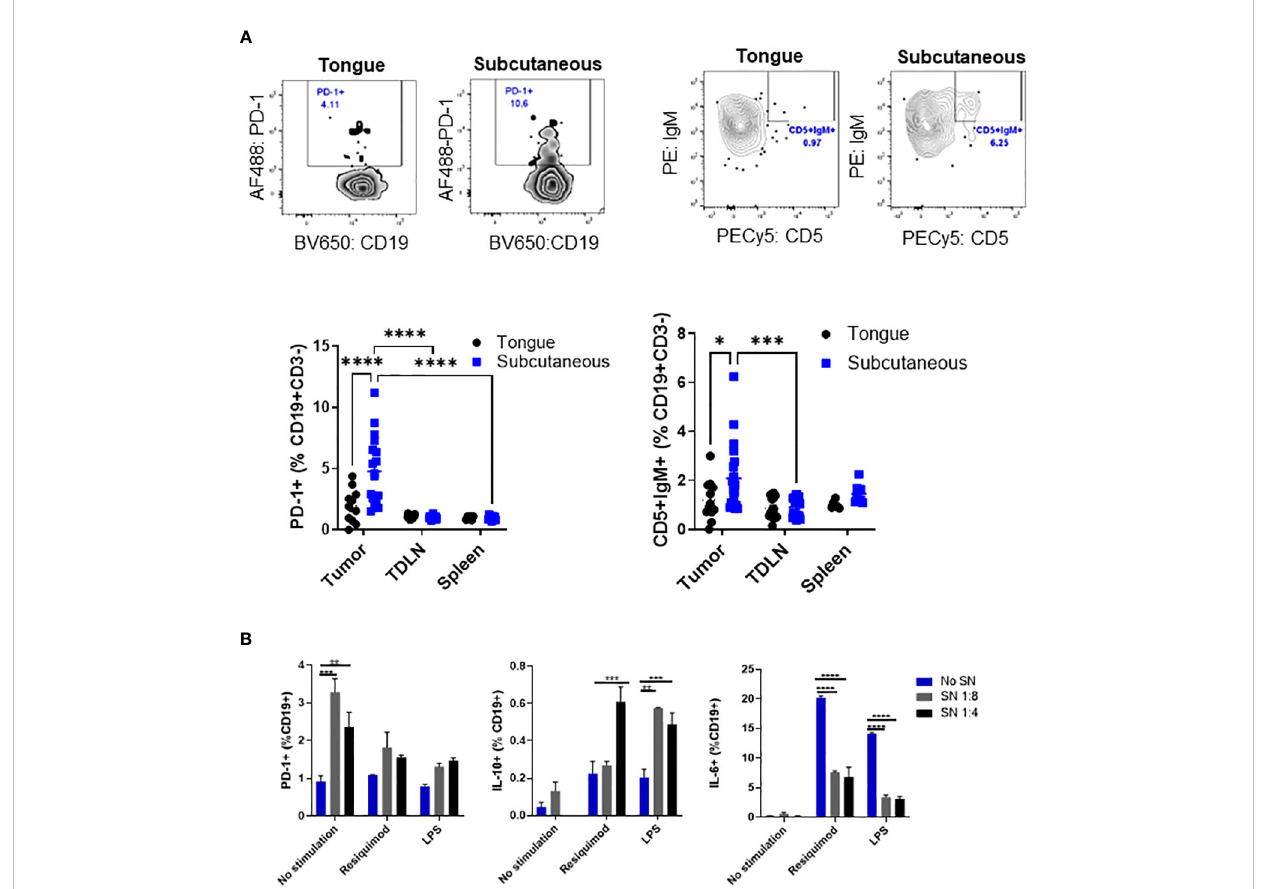
FIGURE 2 Tumor-in fi ltrating B cells express markers related to immunosuppression. C57BL/6 mice were injected with mEER cells in the tongue (5 x 10 4 ) or subcutaneously (1 x 10 6) in the fl ank. The frequency of CD5+ and IgM+PD-1+ cells among CD19+ B cells in tumor, spleen, and tumor-draining lymph nodes were analyzed by fl ow cytometry after 30 days of tumor implantation. Representative fl ow cytometry plots are shown. Results depict pooled data from two experiments (n = 12 - 15 mice/group). Statistical analysis was done with two-way ANOVA test ****p<0.00001, ****p<0.00001, ***p<0.0001, and *p<0.01 (A) . After 24 hours of culture with different dilutions of tumor cell supernatant, we analyzed by fl ow cytometry PD-1 expression, IL-10, and IL-6 expression on stimulated mouse-enriched B cells. Statistical signi fi cance was calculated using a two-way ANOVA test: *p<0.05, **p<0.005, ****p<0.00005 (n = 2). All comparisons were made between diluted supernatant and no supernatant. This is a representative experiment of a total of 2 experiments (B)